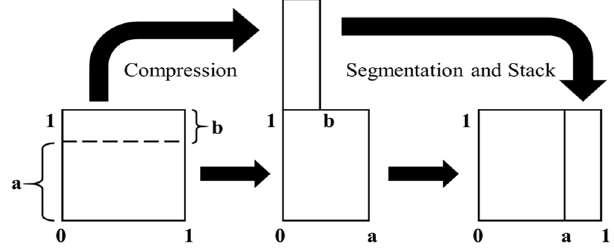
Figure 1. Illustration of the incompressible Baker map.